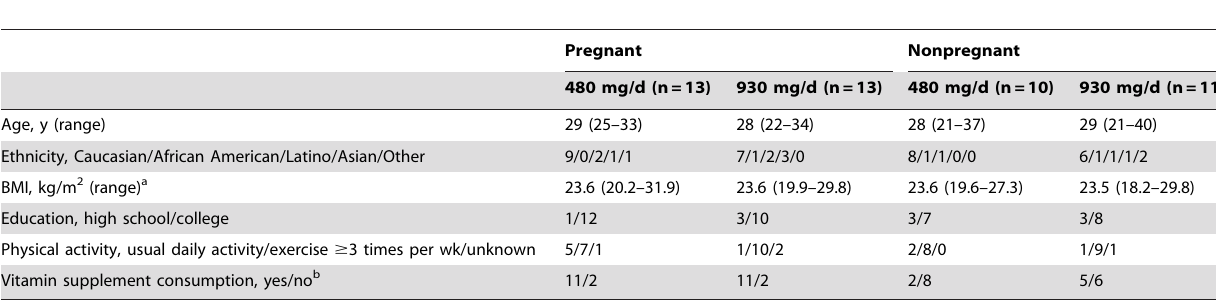
Table 1. Baseline (study week 0) characteristics of third trimester pregnant women and nonpregnant women randomized to either the 480 or 930 mg/d choline intake group.